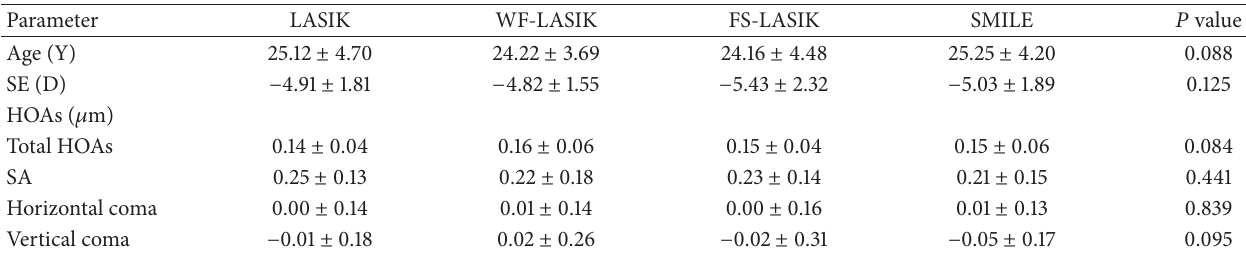
Table 1: Preoperative patient characteristics (mean ± SD).